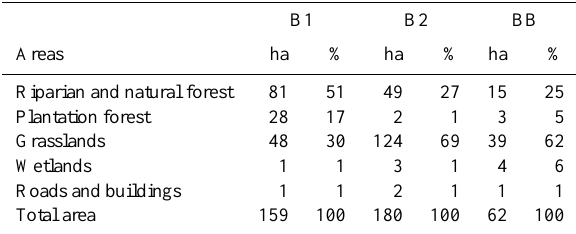
Table 1. Proportion of land use for each